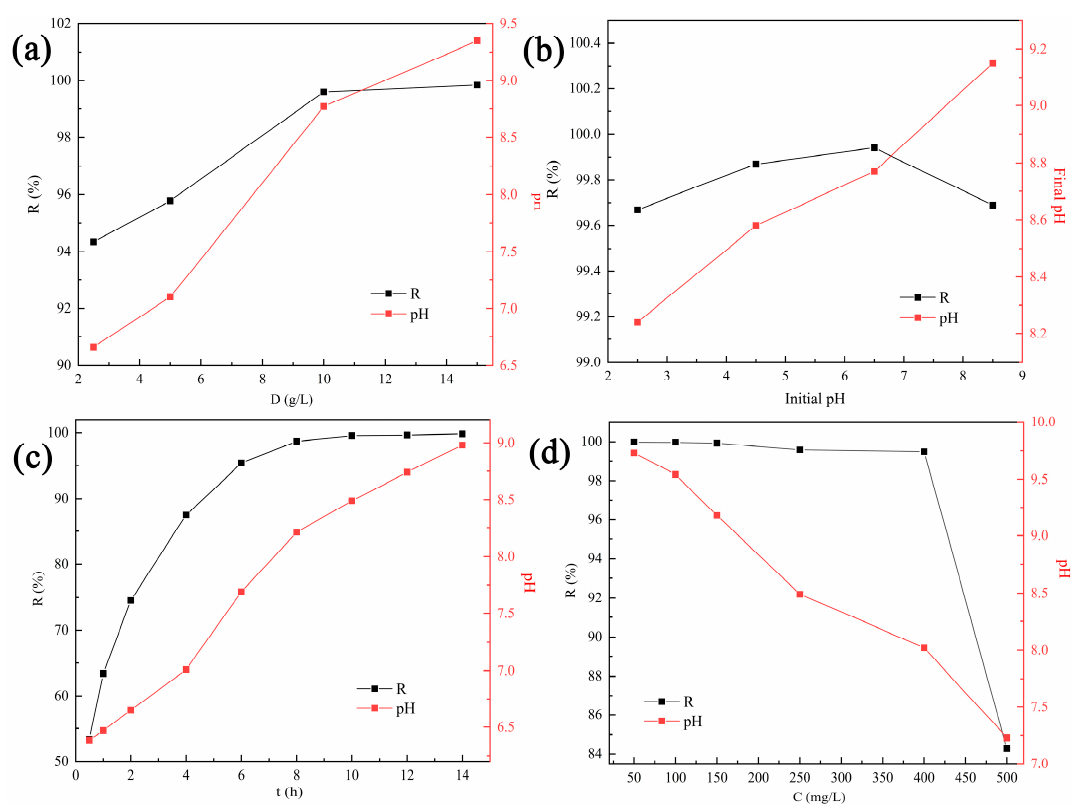
Figure 4. Removal efficiency of Cd 2+ and solution pH at different ( a ) dosages, ( b ) initial solution pH values, ( c ) contact times and ( d ) initial Cd 2+ concentrations.